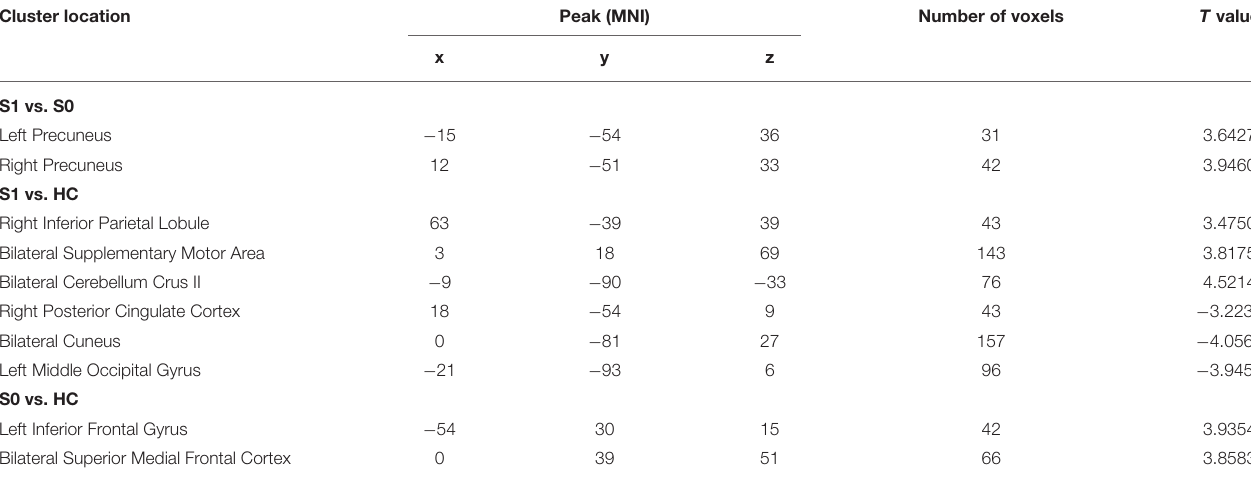
TABLE 2 | Significant ReHo differences across groups.